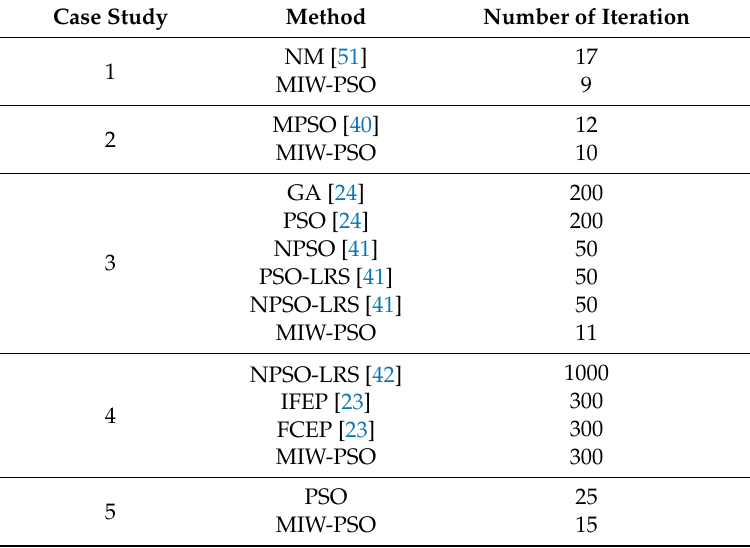
Figure 4. The convergence of the MIW-PSO: ( a ) first case study; ( b ) second case study; ( c ) third case study; ( d ) fourth case study; ( e ) fifth case study. Table 15. Comparison of the convergence test among different methods.